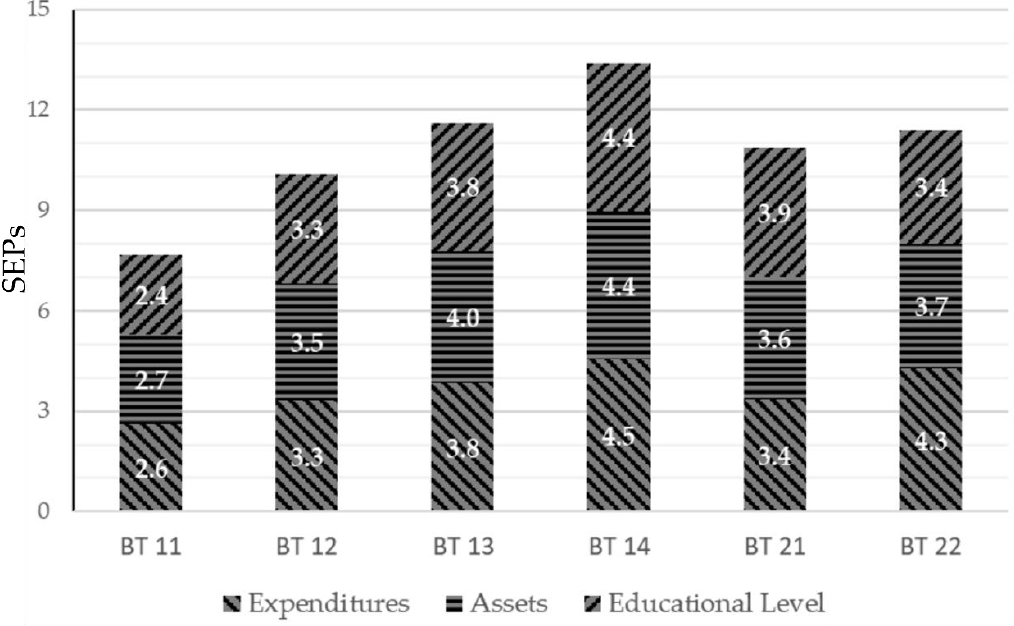
Figure A2. SEPs per building type. As described in Section 2.2.6, total SEP are composed of household expenditures, household assets, and educational level of household main earner.